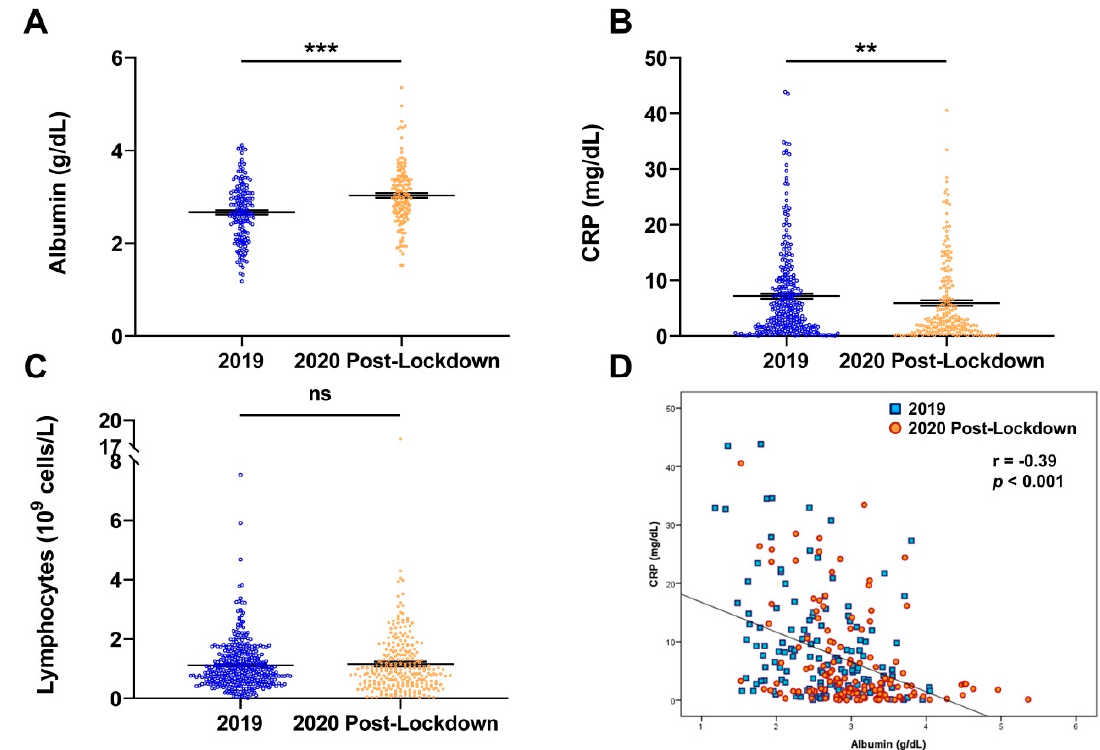
Figure 4. Distribution of circulating albumin ( A ), C -reactive protein (CRP) ( B ), and lymphocytes ( C ) as well as the correlation between albumin and CRP levels ( D ) in patients admitted in 2019 and 2020. Differences were computed by two-tailed Student’s t -tests ( A – C ). Correlation ( D ) analysis was performed by Pearson’s correlation coefficient; ns, non-significant; ** p < 0.01; *** p <